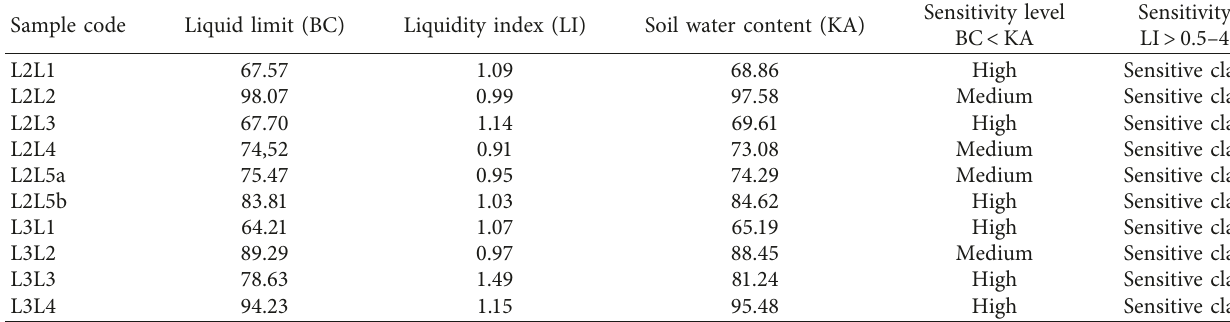
Table 3: Selective samples of sensitivity level of clay.